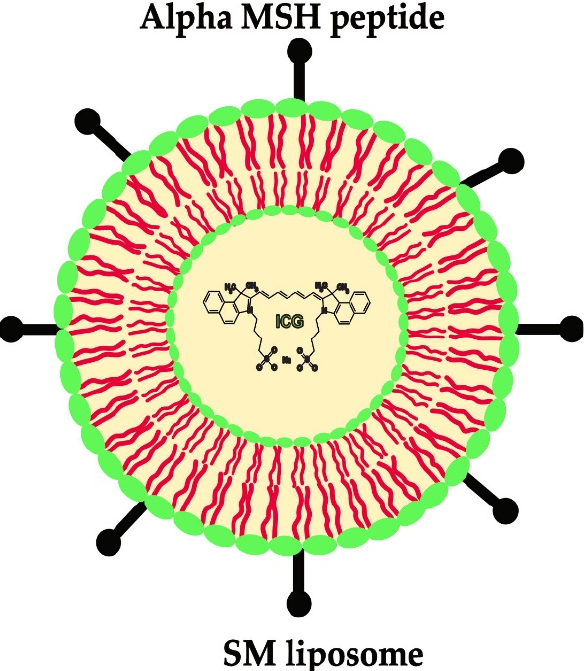
Figure 1. A schematic presentation of the liposomes coupled with α -MSH peptide to make macrophage-specific SM-liposomes. The α -MSH peptide ( ● ▬ ) is covalently coupled to the lipid membrane. The indocyanine dye is encapsulated in the core as a payload.